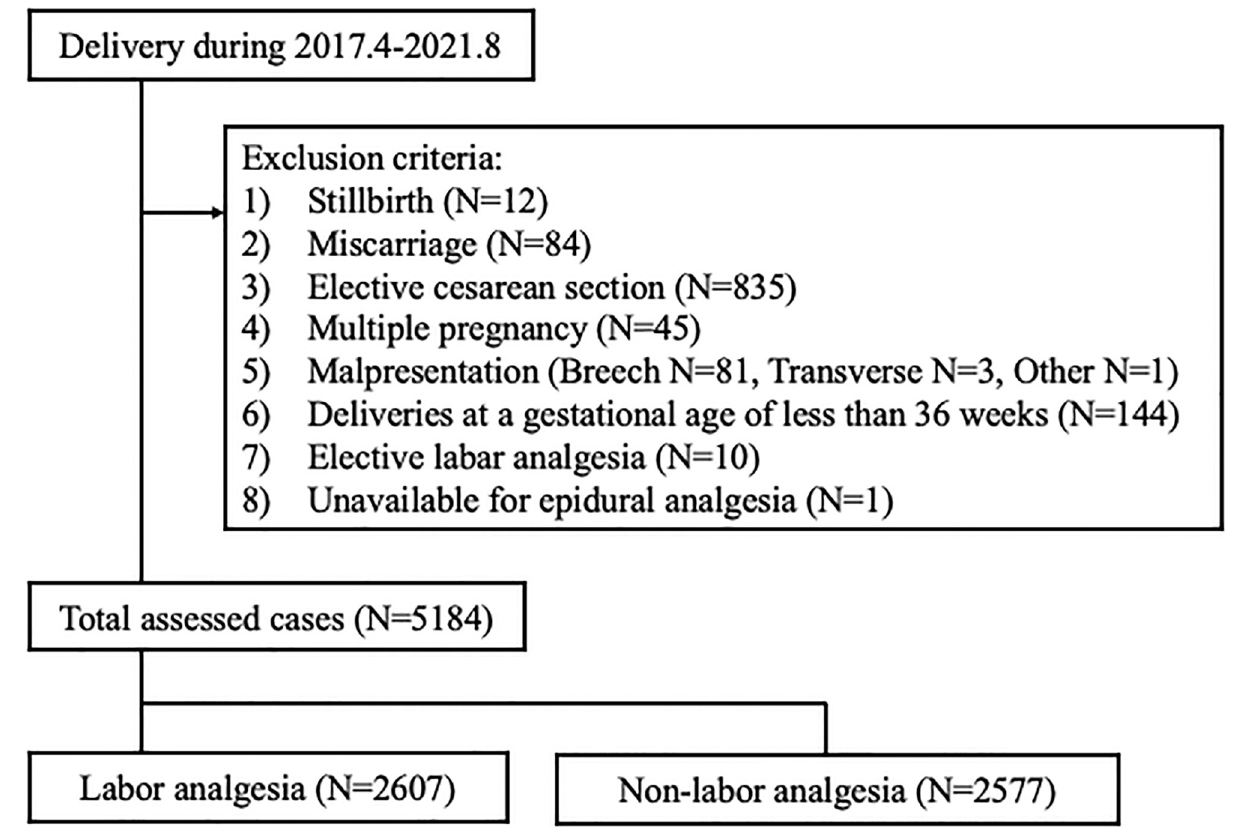
Fig 1. The study patient flow